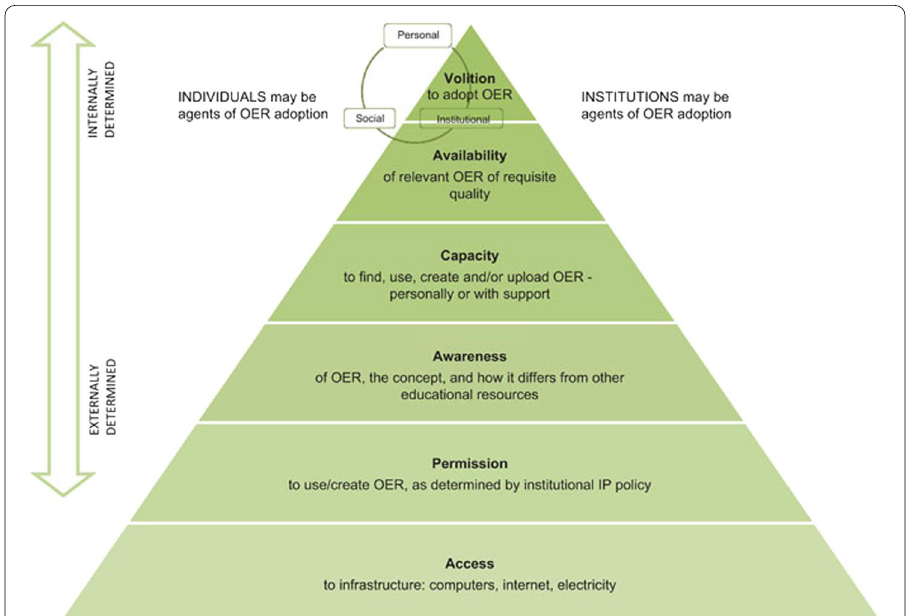
Fig. 1 OER adoption pyramid. Note From “An OER framework, heuristic and lens: Tools for understanding lecturers’ adoption of OER” by G. Cox and H. Trotter, 2017, Open Praxis, 9 (2), p. 155. (https:// doi. org/ 10. 5944/ openp raxis.9. 2.